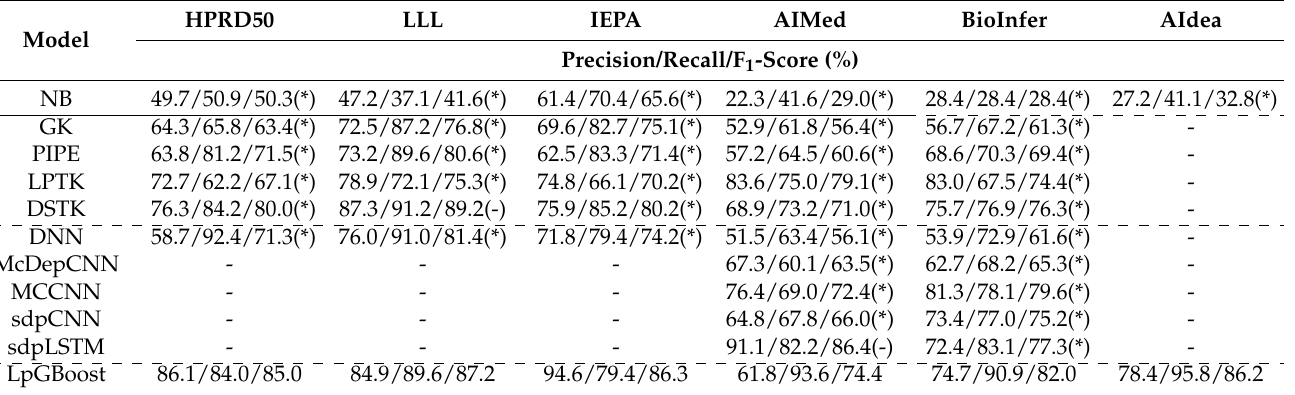
Table 5. Ten-fold CV comparative performance evaluation on PPI corpora. A one-tailed t -test was applied to determine whether our proposed model (LpGBoost) significantly improves the performance of the F 1 -score of the comparisons, where * represents t -tests with alpha = 0.05.